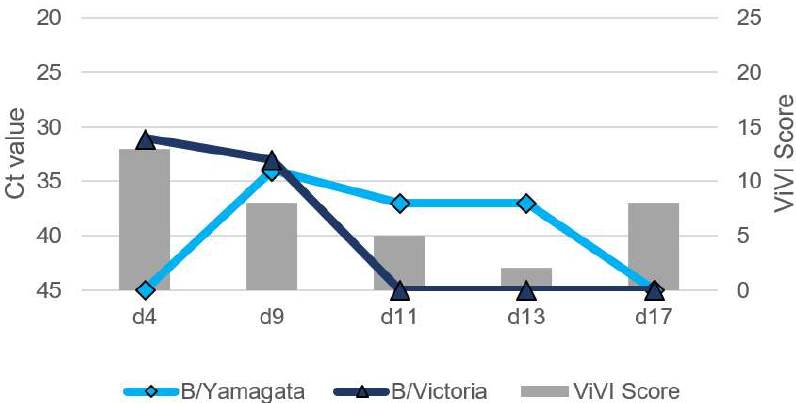
Figure 5. Patient 2 presenting with influenza B/B virus dual infection. Virus load (left inverted vertical axis) as approximated by Ct values correlated with ViVI Scores (right vertical axis) reflecting increasing disease severity with increasing values.